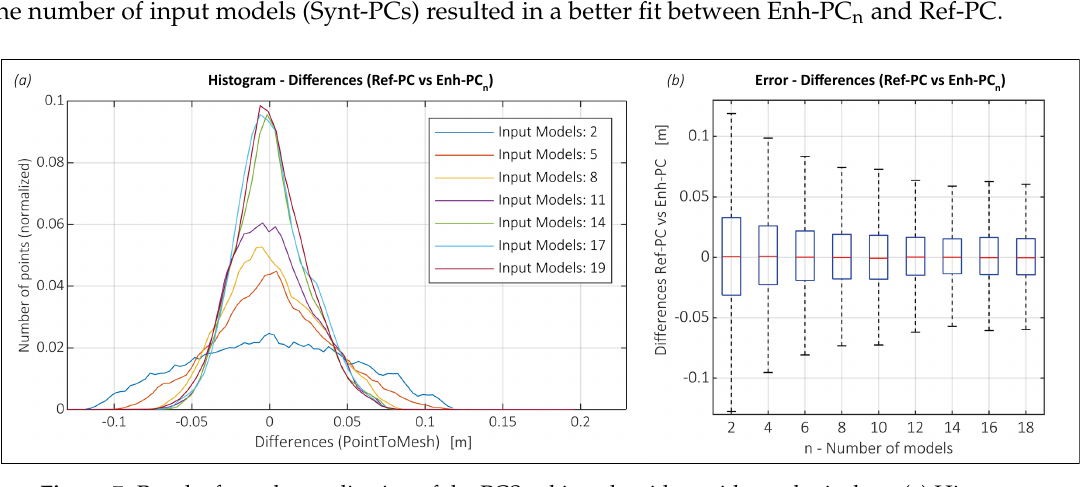
Figure 7. Results from the application of the PCStacking algorithm with synthetic data. ( a ) Histogram of the di ff erences between the Enh-PC n and the Ref-PC. Each colored line represents a di ff erent number of Synt-PCs introduced into the PCStacking algorithm. ( b ) Boxplot with the errors of the di ff erences obtained in the di ff erent comparisons (Enh-PC n vs.